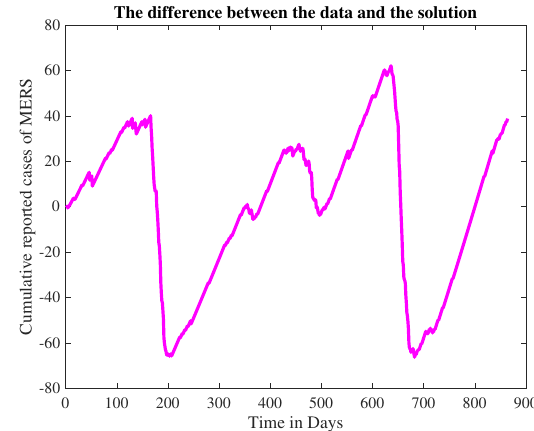
Fig. 9: The difference between the data and the model solution in Fig.2